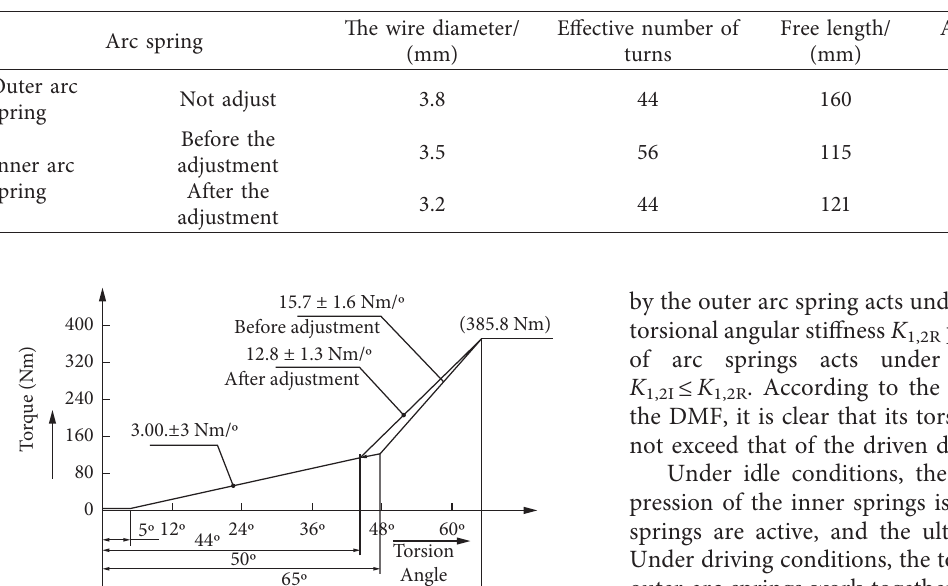
Table 5: Arc spring parameter adjustment.